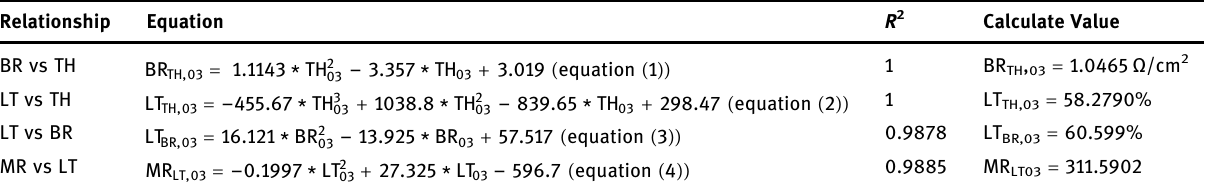
BR – block resistance; TH – fi lm thickness; LT – light transmittance; and MR – material resistivity. R 2 is an indicator of the fi tting degree of the equation to the data set when performing linear regression. A value of 1 indicates a fi t of high reliability.